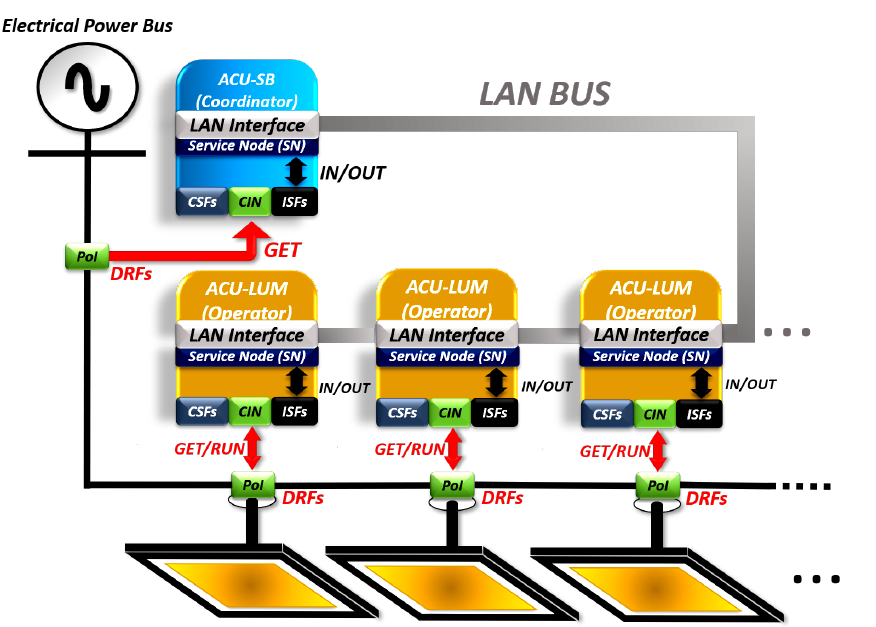
Figure 3. Architecture of the proposed system based on the adaptation of the SmartLVGrid metamodel for smart building convergence.